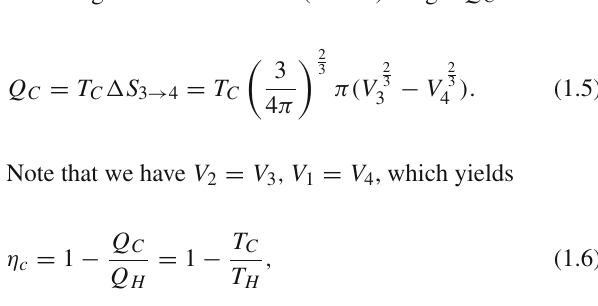
and along the lower isotherm (3 → 4) we get Q C